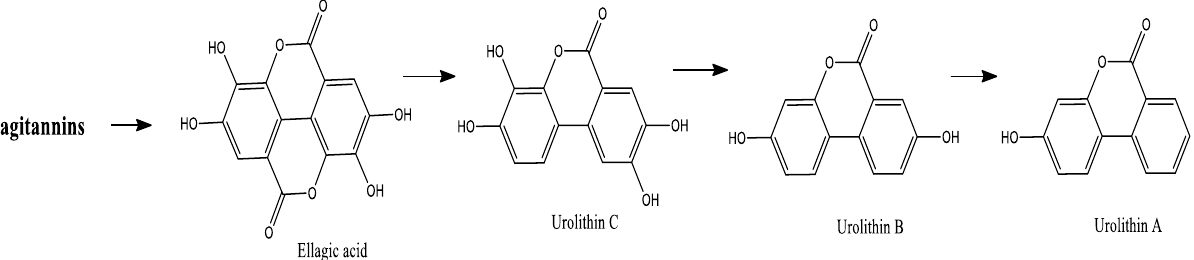
Figure 3. Microbial metabolism of ellagitannins.